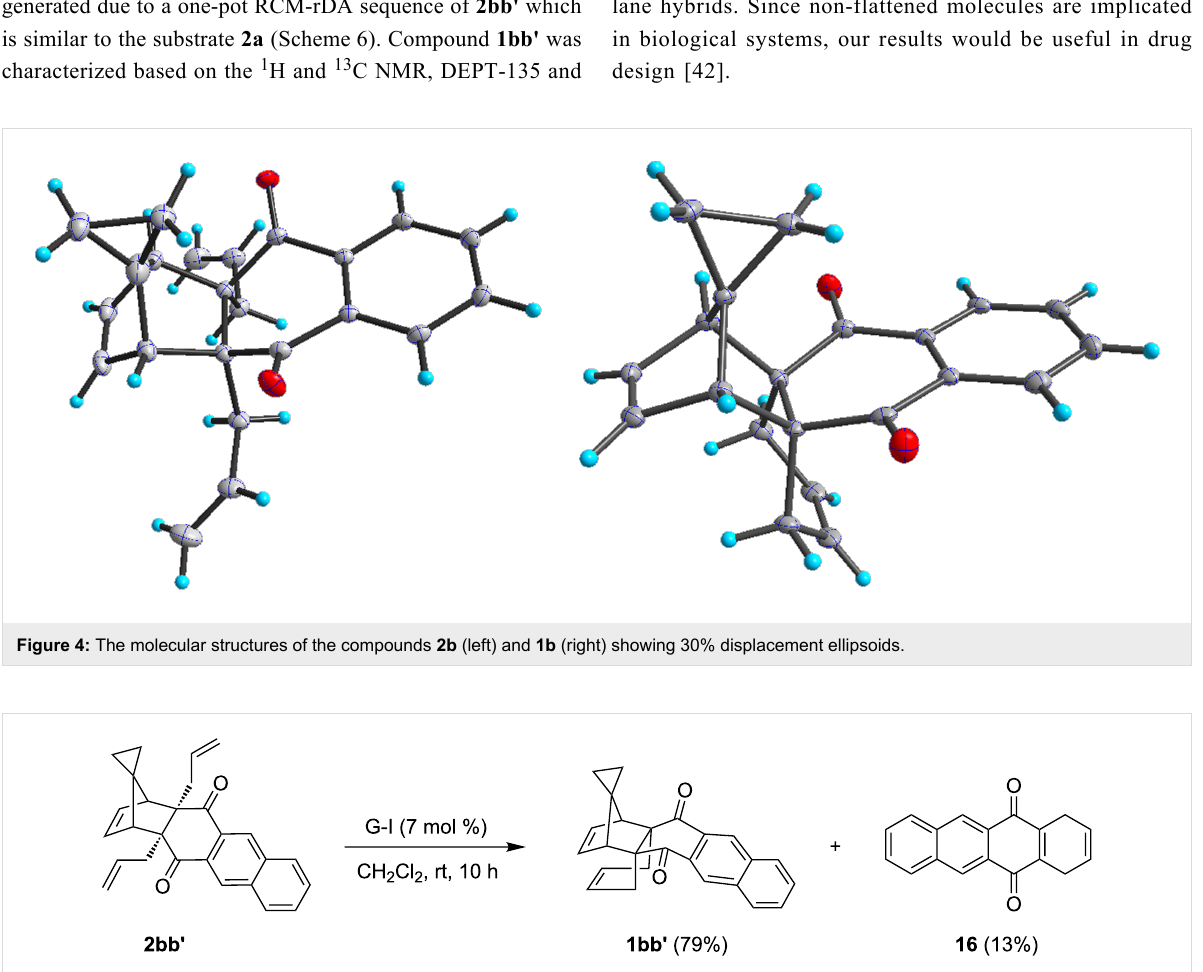
(Figure 4). Based on this data it is clear that the bridgehead allyl groups in the RCM precursor 2b are in endo